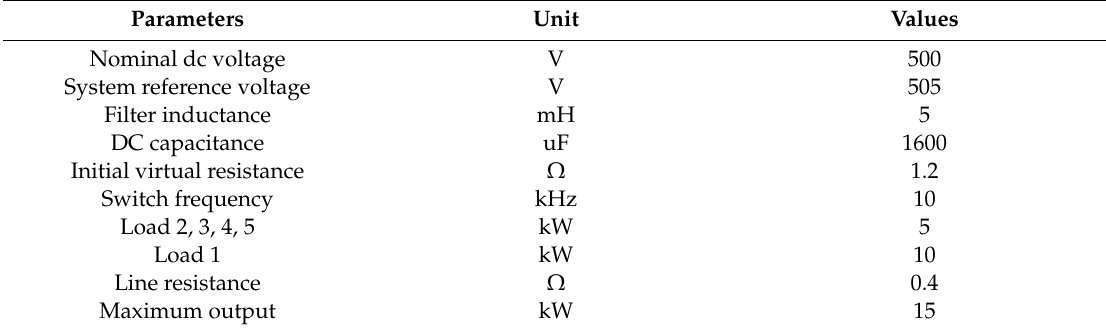
Table 2. Parameters of primary level. Table 1. Cost function parameters of DGs.